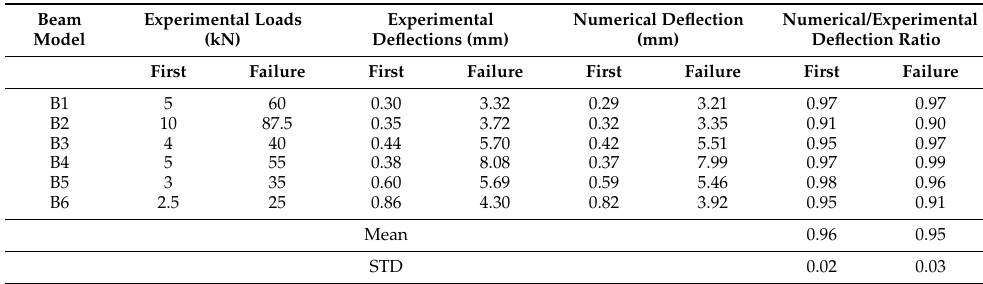
Table 4. Comparison of the experimental and numerical results of the mid-span deflections of the beam models at the first cracking load and at failure.